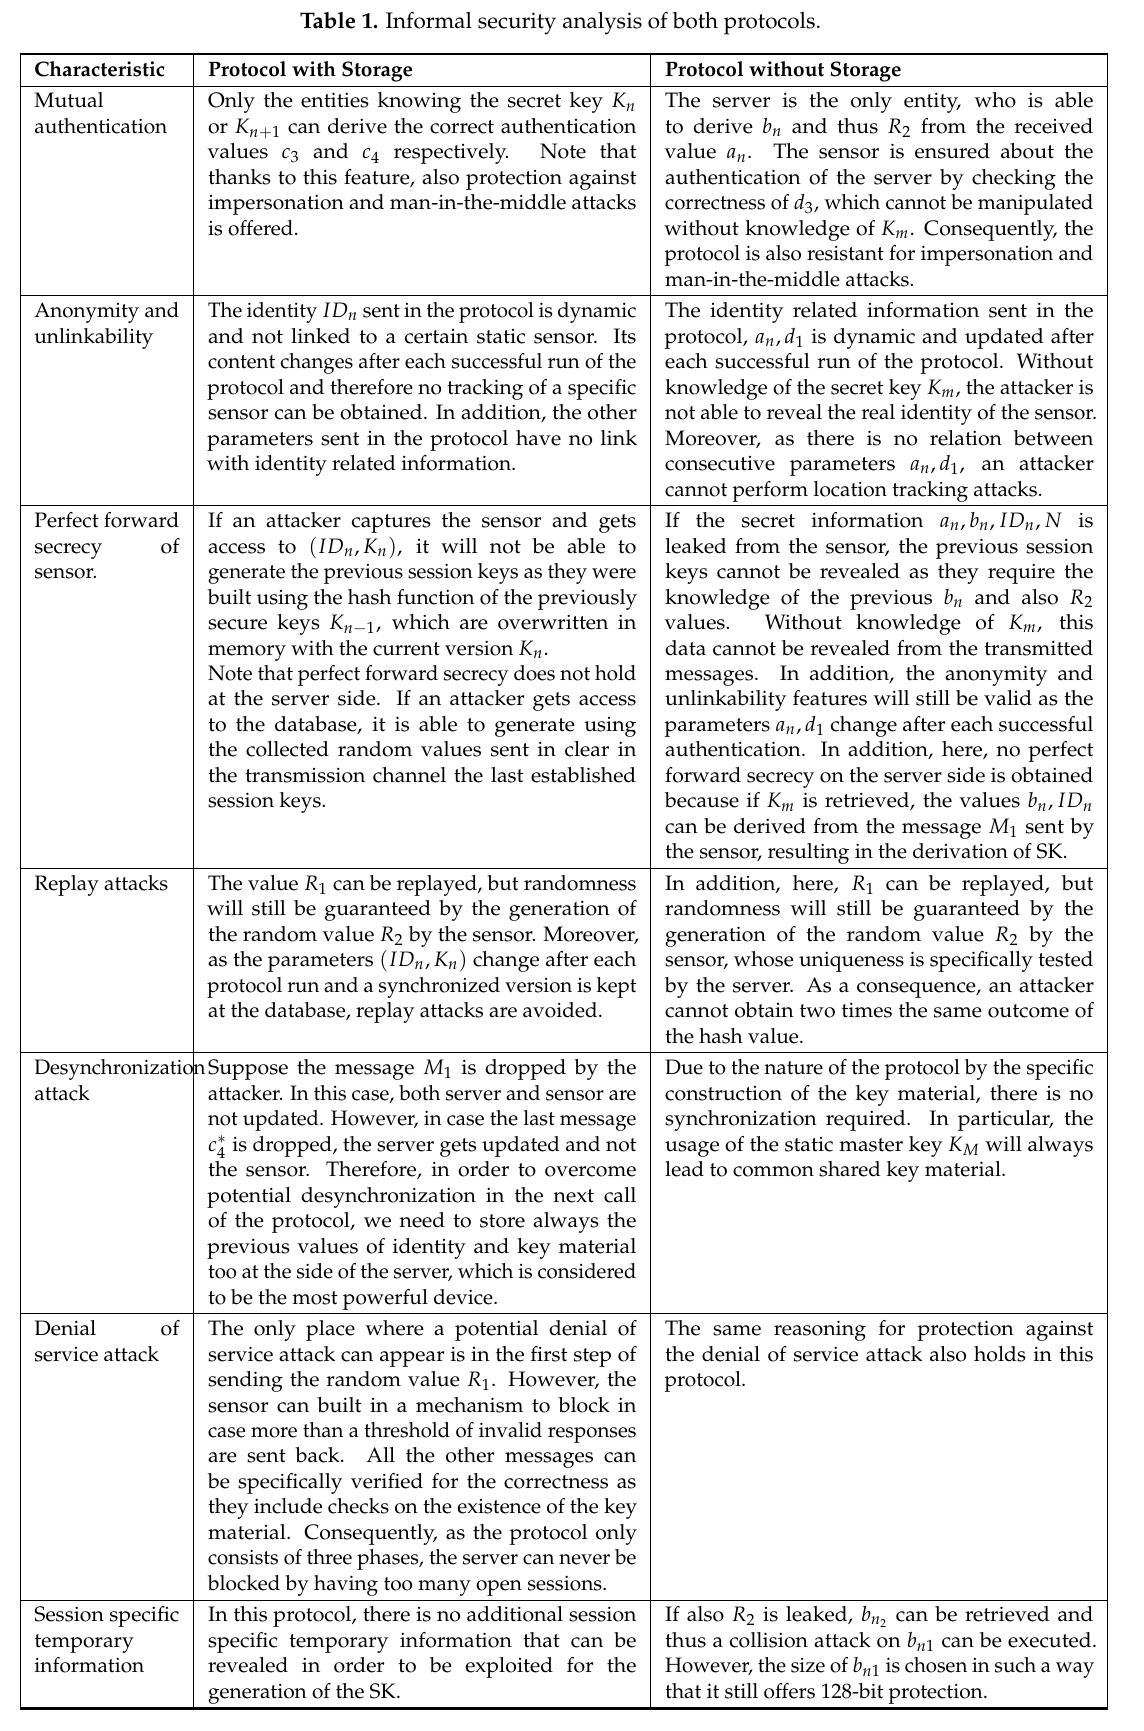
Table 1. Informal security analysis of both